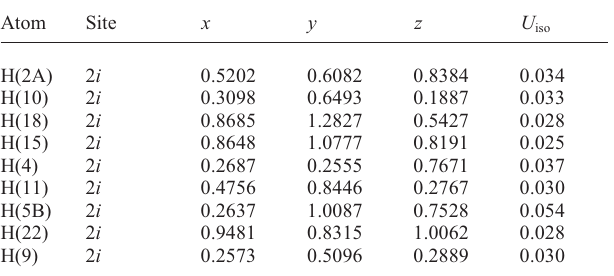
Table 3. Atomic coordinates and displacement parameters (in Å 2 )